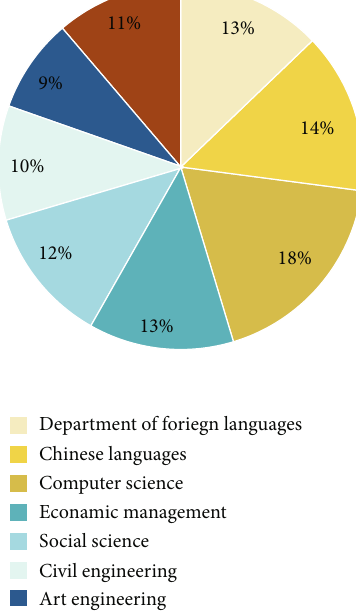
Figure 3: UPI tests the distribution of class personnel in